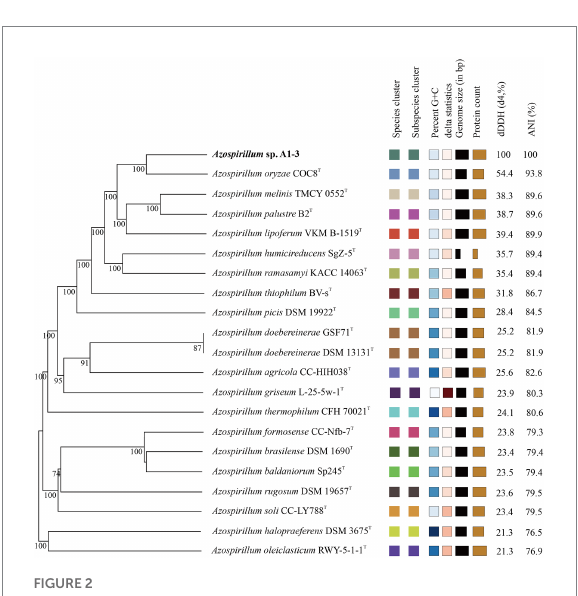
FIGURE 2 The whole-genome evolution tree of A1-3 and related bacteria with dDDH and ANI